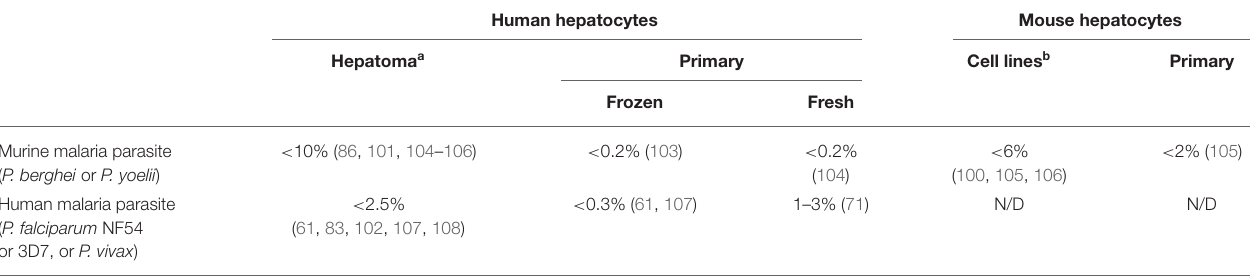
TABLE 3 | The malaria parasite rate of infection in hepatocytes. Human hepatocytes Mouse hepatocytes Hepatoma a Primary Cell lines b Primary Frozen